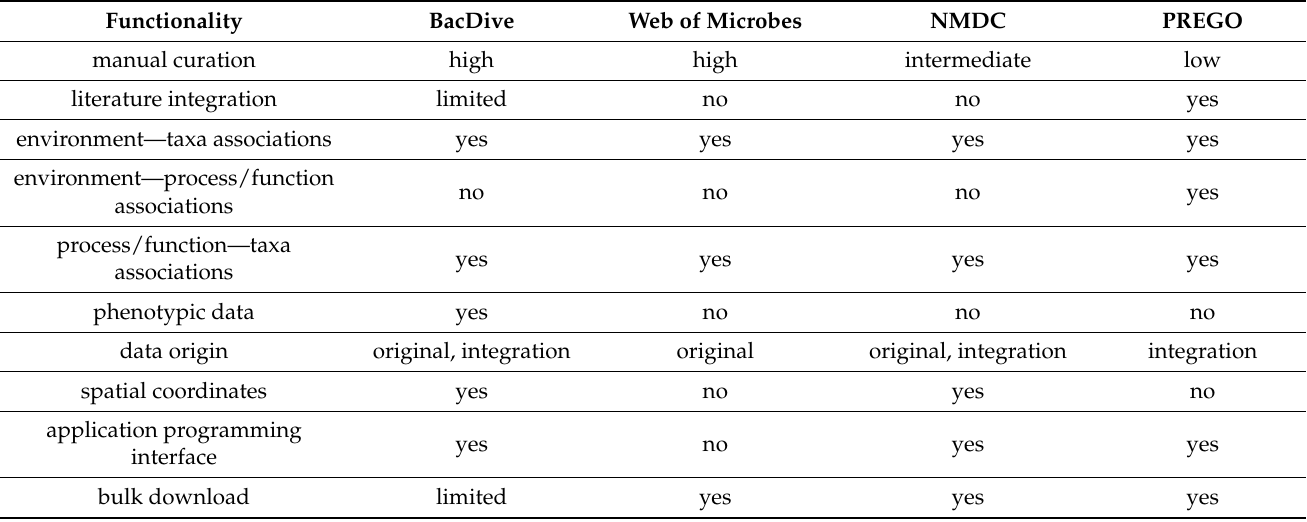
Table 4. Feature comparison among platforms that facilitate knowledge discovery and integration of microbial